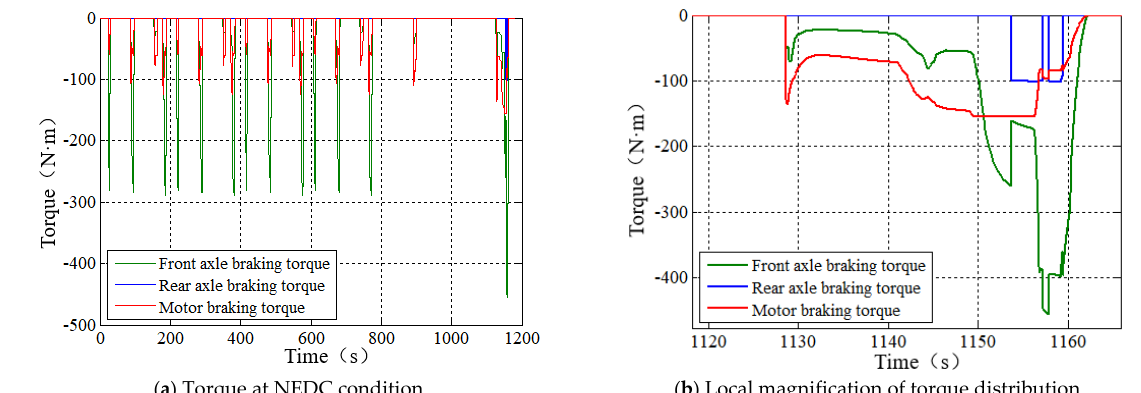
Figure 12. Vehicle braking torque distribution in the NEDC condition.